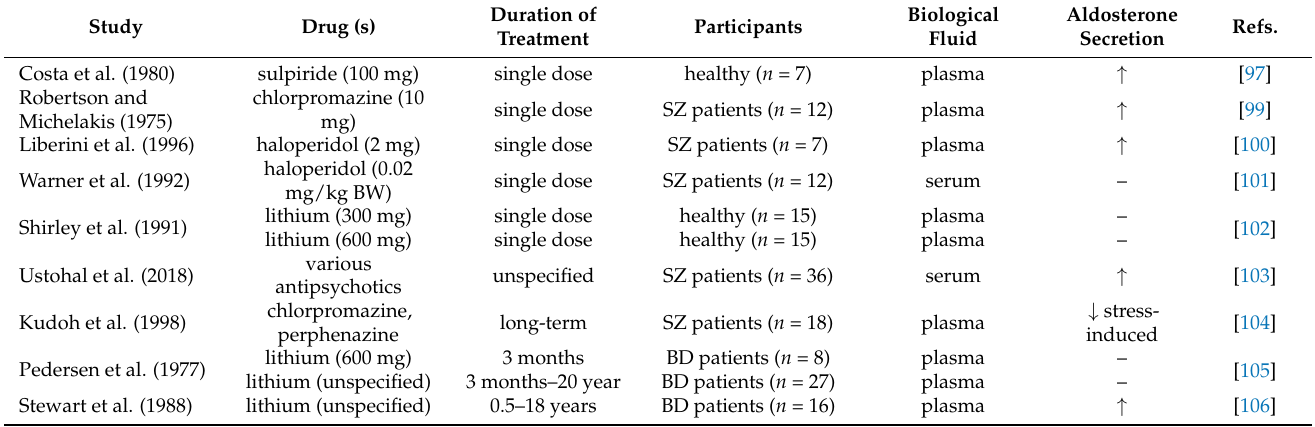
Table 3. Summary of findings from studies investigating changes in aldosterone concentrations following antipsychotic drug treatment in healthy subjects and